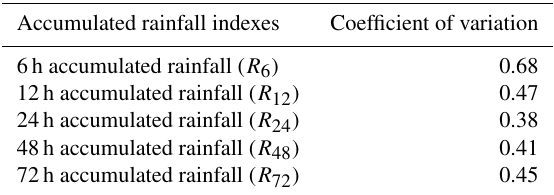
Table 4. Coefficient of variation of different accumulated rainfall